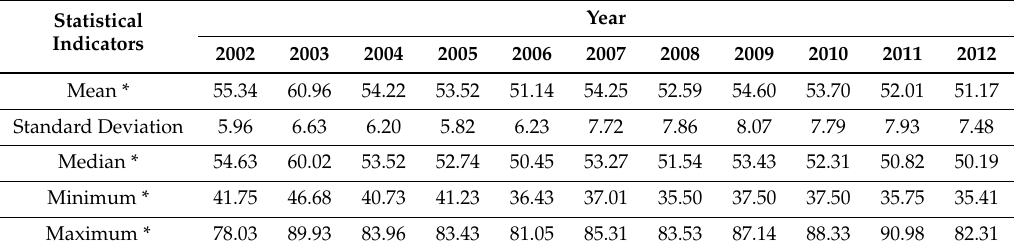
Table 1. Descriptive statistics of NO 2 concentrations across the study period (2002–2012) for